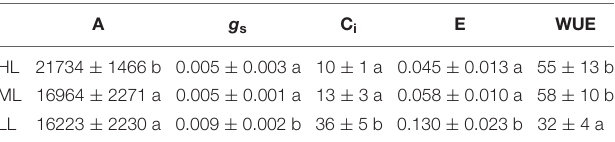
TABLE 2 | Photosynthesis, stomatal conductance, substomatal concentration of CO 2 , transpiration and water use efficiency of cv. Propino plants grown under different light intensities. A g s C i E WUE HL 21734 ± 1466 b 0.005 ± 0.003 a 10 ± 1 a 0.045 ± 0.013 a 55 ± 13 b